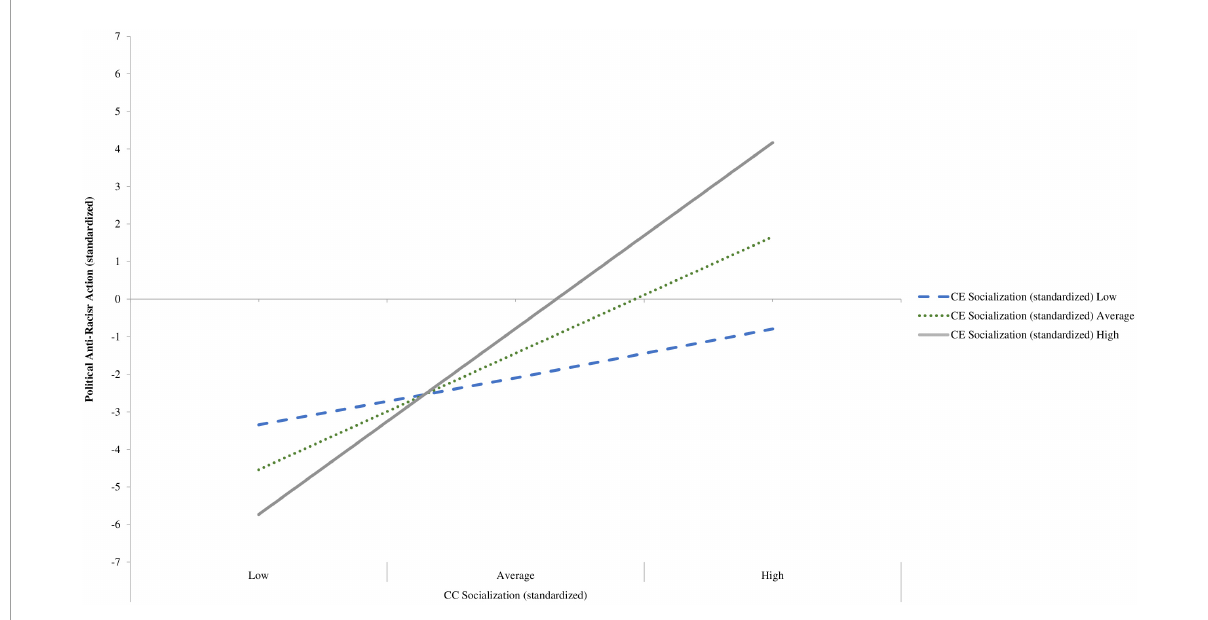
FIGURE2 Graph of simple slopes analysis, political anti-racist